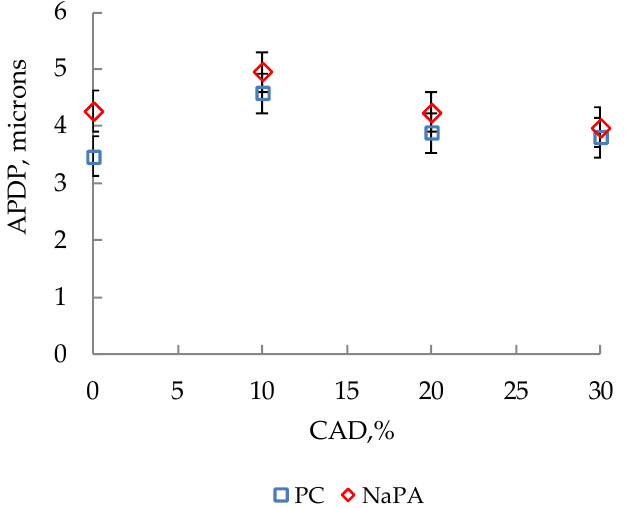
Figure 9. Changes in the minimum average diameter of particles in suspensions with different film-forming agent content.